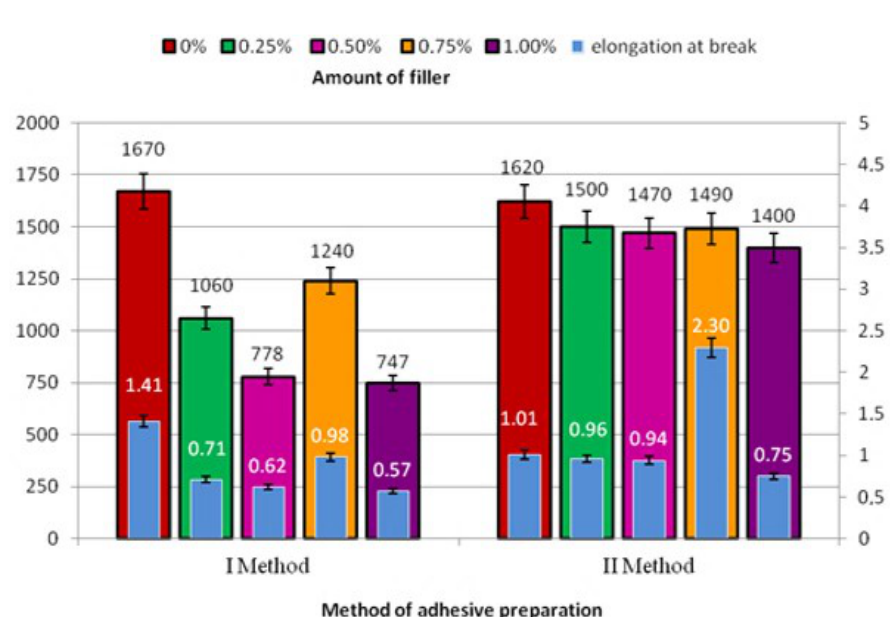
Figure 3. Maximum force and elongation of adhesive joints produced according to Methods I and